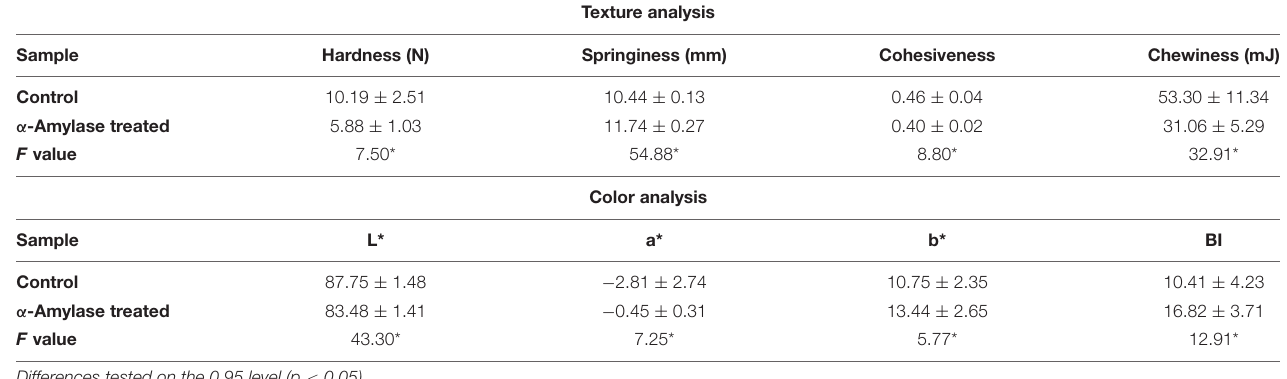
TABLE 2 | Texture and color analysis of wheat bread before and after addition of enzyme.